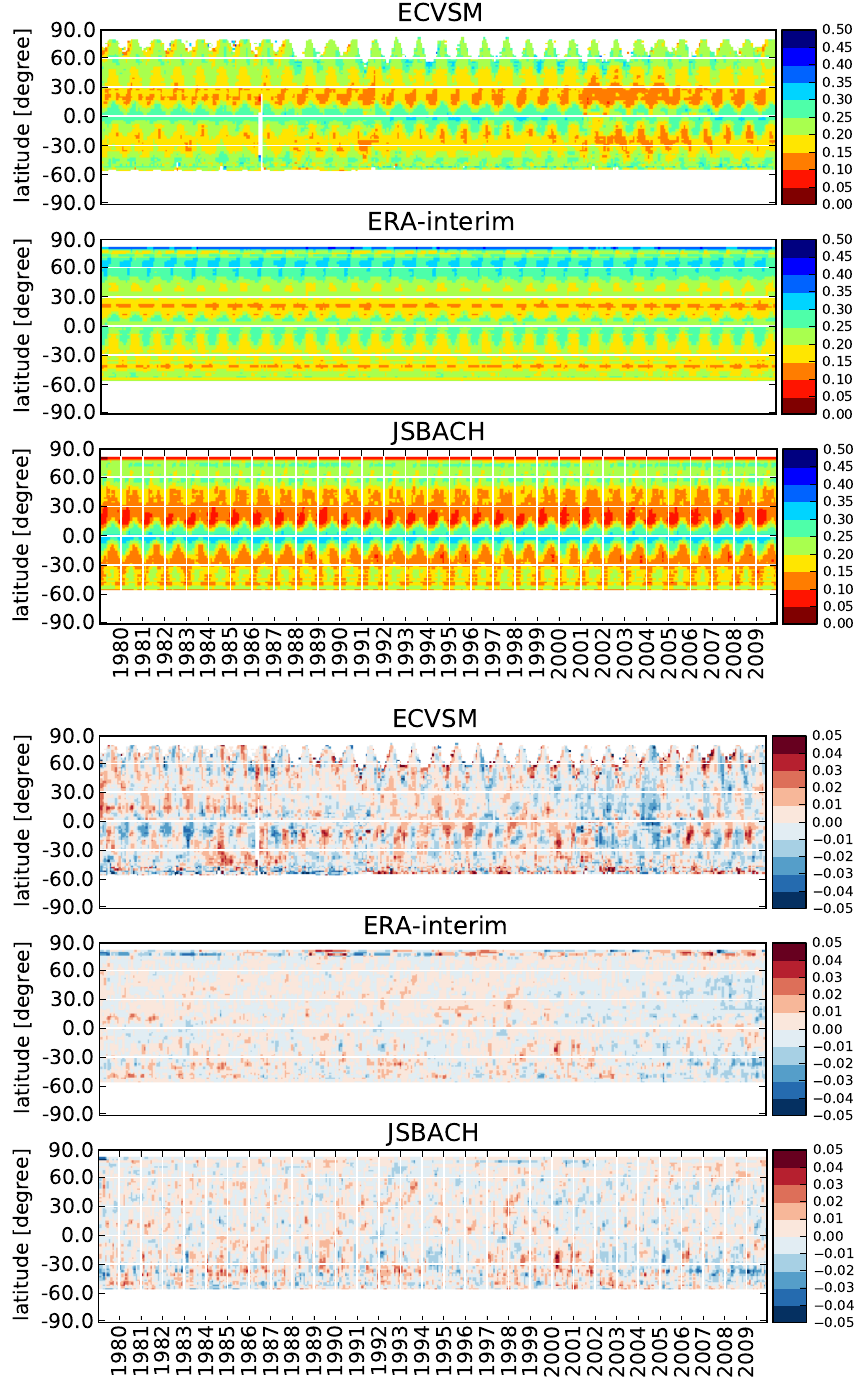
Fig. 3. Time-latitude diagrams for monthly mean volumetric surface soil moisture and surface soil moisture anomaly datasets [m 3 m − 3 ].